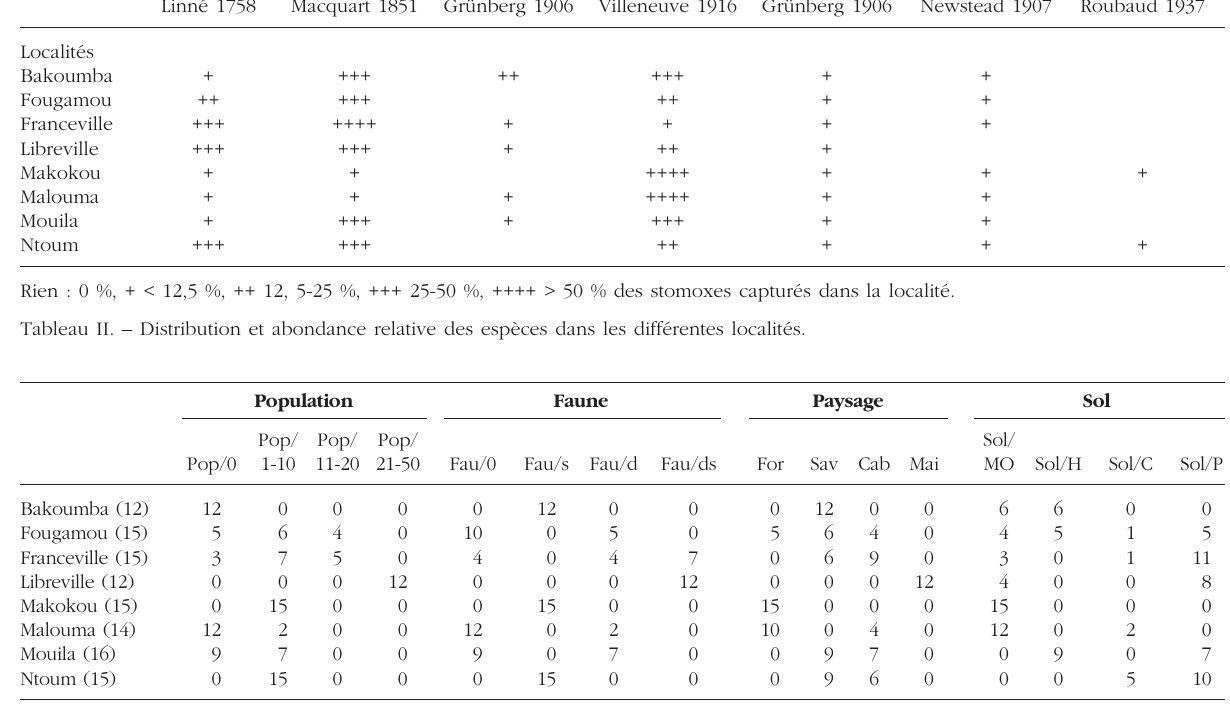
Tableau III. – Distribution des pièges entre les différentes modalités de paramètres (abréviations : voir tableau